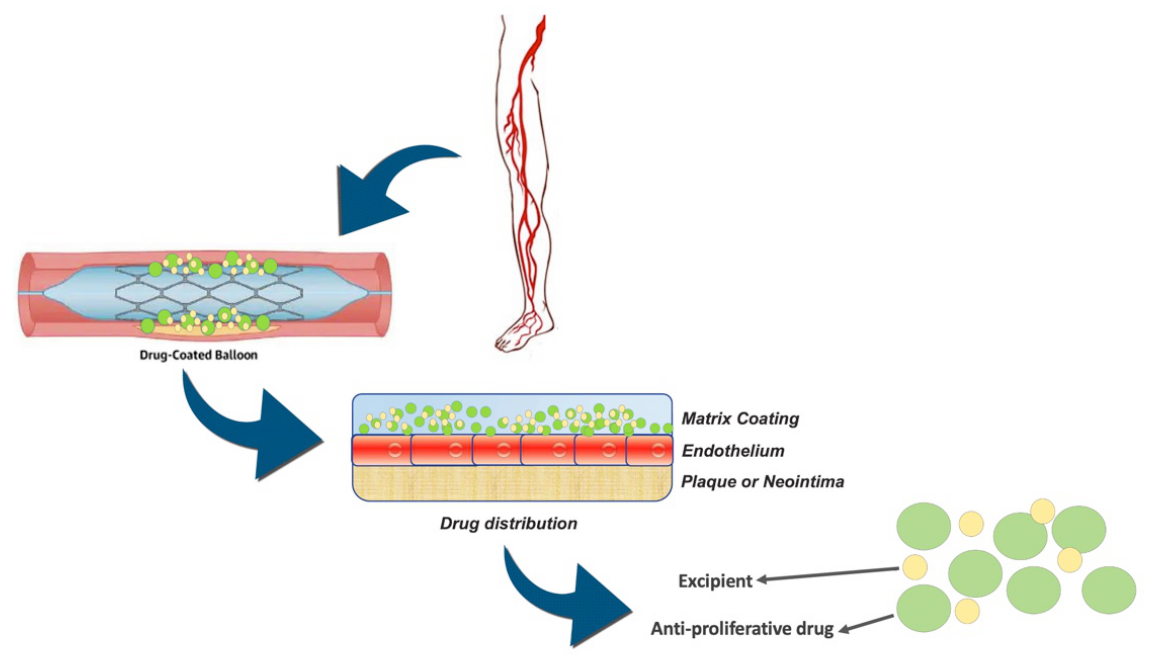
Figure 1. Mechanism of action of the drug-coated balloon and drug distribution through the